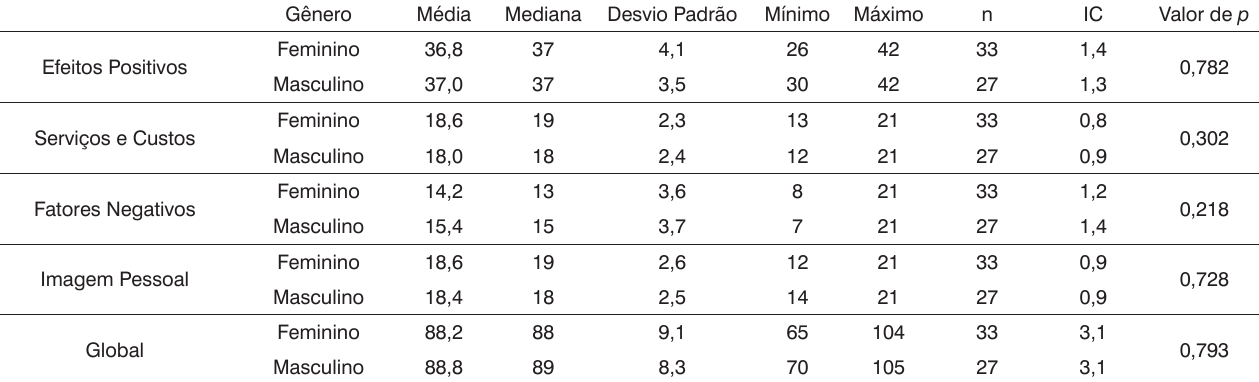
Teste estatístico: ANOVA; nível de significância p ≤ 0,05. n: número de sujeitos; IC: intervalo confiança.